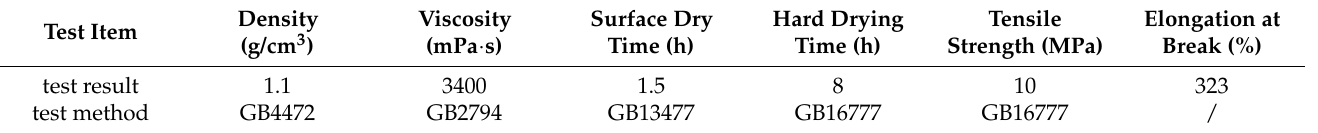
Table 5. Properties of polyurethane adhesive.